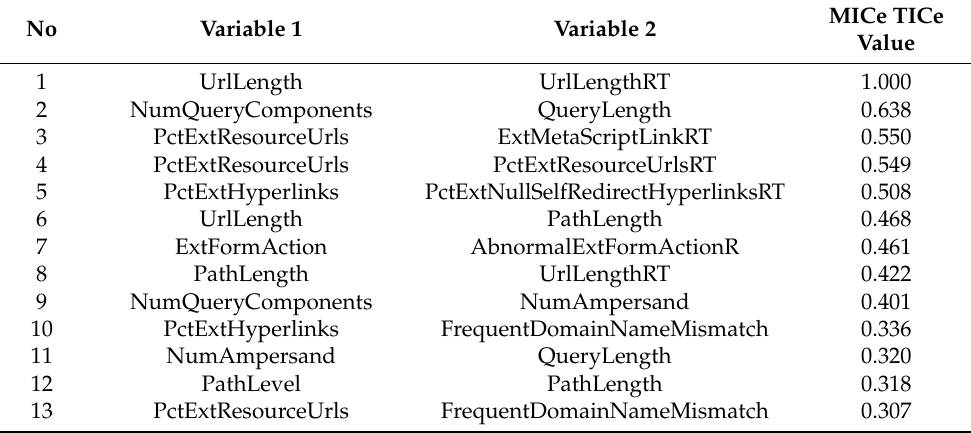
Table 7. MICe TICe correlation value between features on dataset